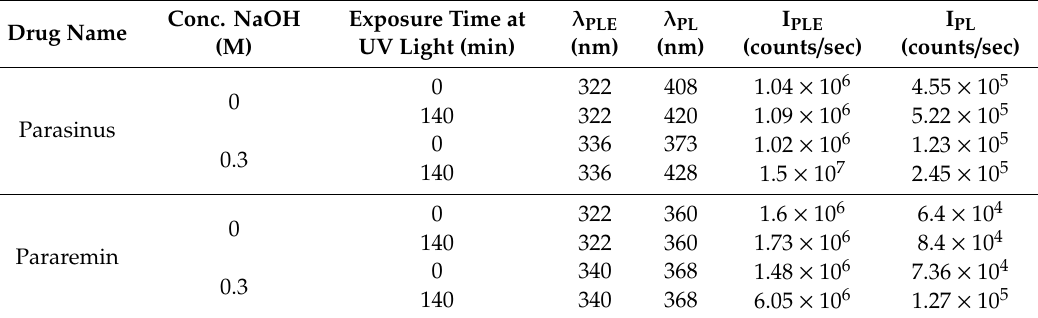
Table 1. The dependence of the maximum and the intensity of PLE and PL spectra of Parasinus and Pararemin as depending on the exposure time to UV light and the interaction with